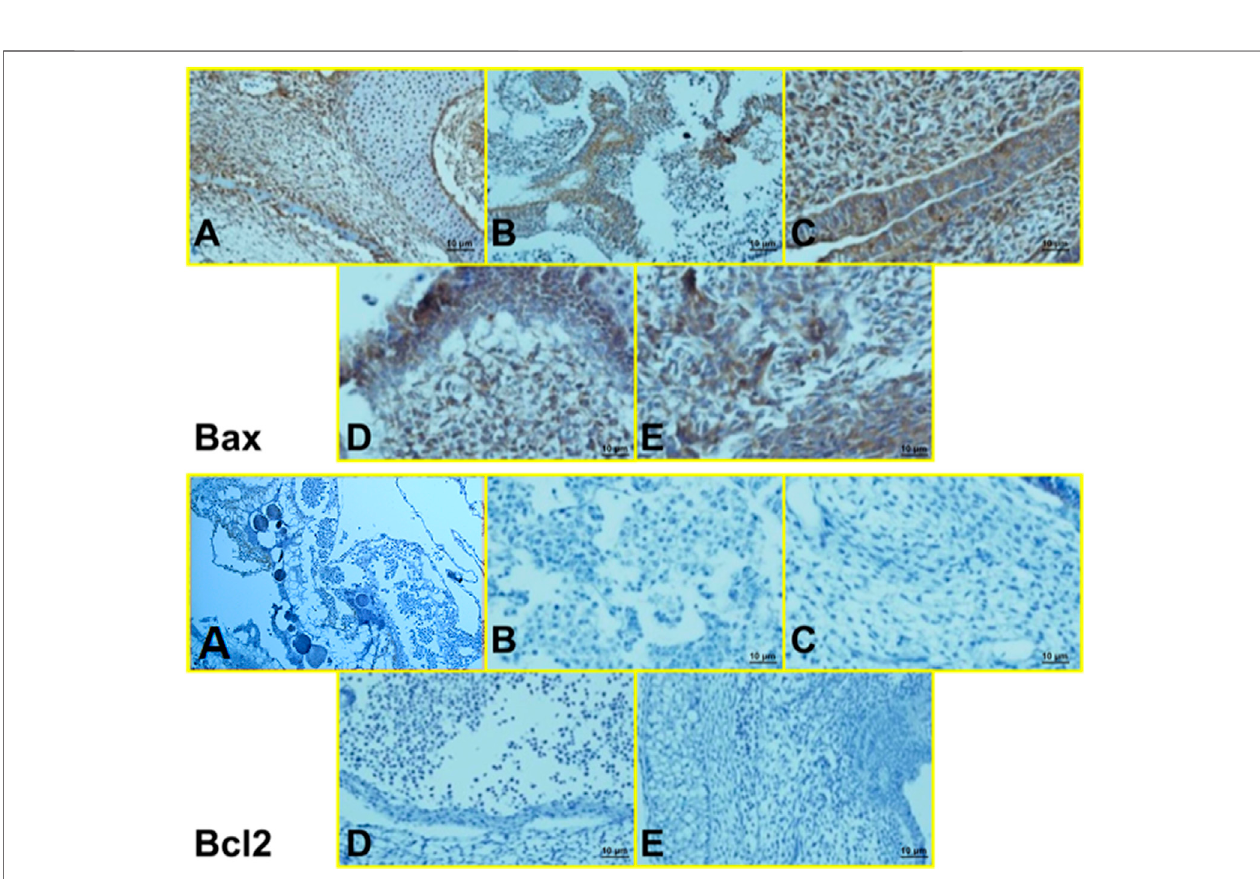
FIGURE10| Microscopyimages ofIHCstainingofBax(up)and Bcl2(down)fromchickembryoin (A) controlgroup, (B) AmpB1X, (C) AmpB2X, (D) AmBisome 1X, (E) AmBisome 2X (40X).